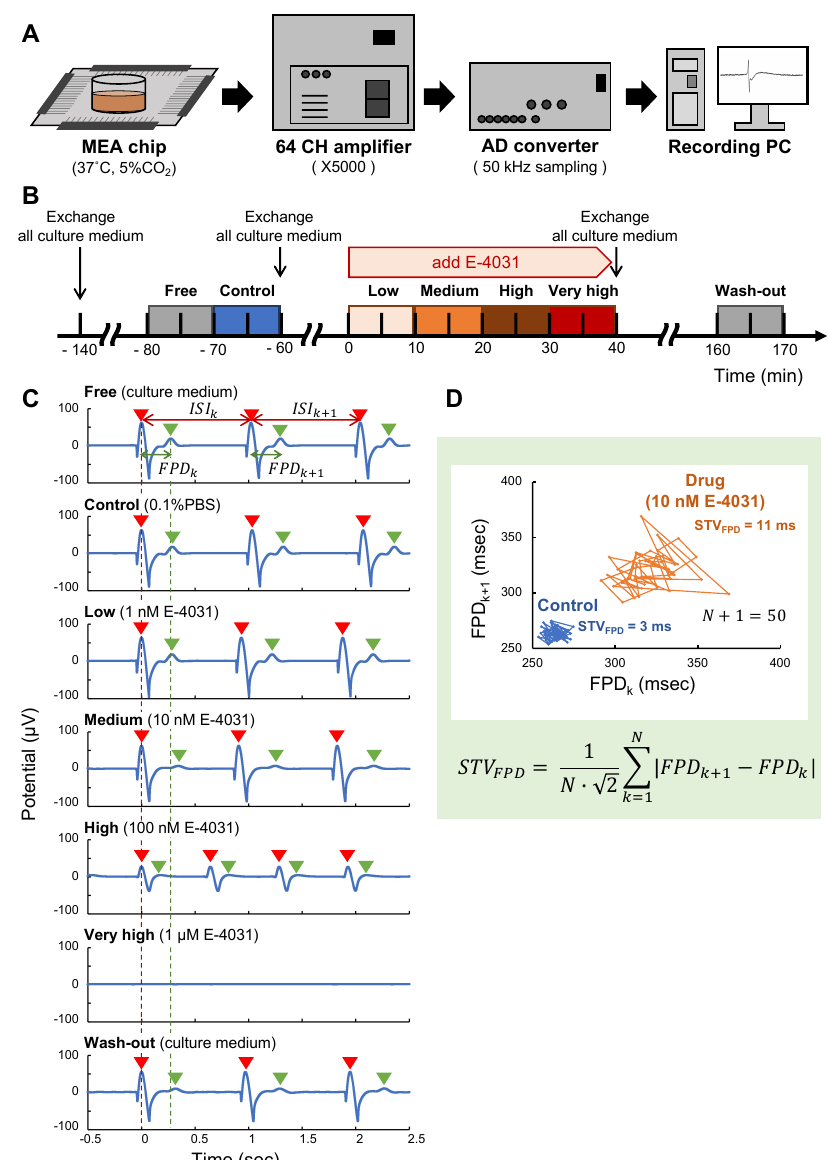
Figure 3. Experimental designs of extracellular field potential measurement of cardiomyocyte networks: Evaluation of hERG ion channel blocking with E-4031. ( A ): schematic drawing of the MEA measurement system. The extracellular field potentials (FPs) of cardiomyocytes on the microelectrodes were amplified and digitally recorded for FP waveform analysis. ( B ): time-course of drug administration procedure. The FPs of cardiomyocytes on a microelectrode were measured at seven different solution states in MEA chips: Free (only culture medium), Control (0.1% PBS dose), Low (1nM E-4031 dose), Medium (10nM E-4031 dose), High (100nM E-4031 dose), Very high (1µM E-4031 dose) and Wash-out (only culture medium). ( C ): representative FP waveforms of large square sheet cardiomyocyte network at every seven states. The red and green arrowheads indicate each FP waveform’s first and last FP peaks, respectively. The FPD prolongation, an increase of the time distance of those first and last FP peaks, was observed at the Medium state. The fibrillation-like weak and faster ISI waveform was observed at High state. An arrest of FP waveforms was recorded at Very high condition. ( D ): The evaluation of FPD fluctuation caused by hERG ion channel blocking effect with E-4031 of cardiomyocyte networks. The Poincaré plots of FPDs in Control (blue, STV = 3ms) and Medium (Orange, STV = 11 ms) states were described in the graph. These visualized fluctuations of FPD were evaluated and quantified by calculating the short-term variability (STV) of